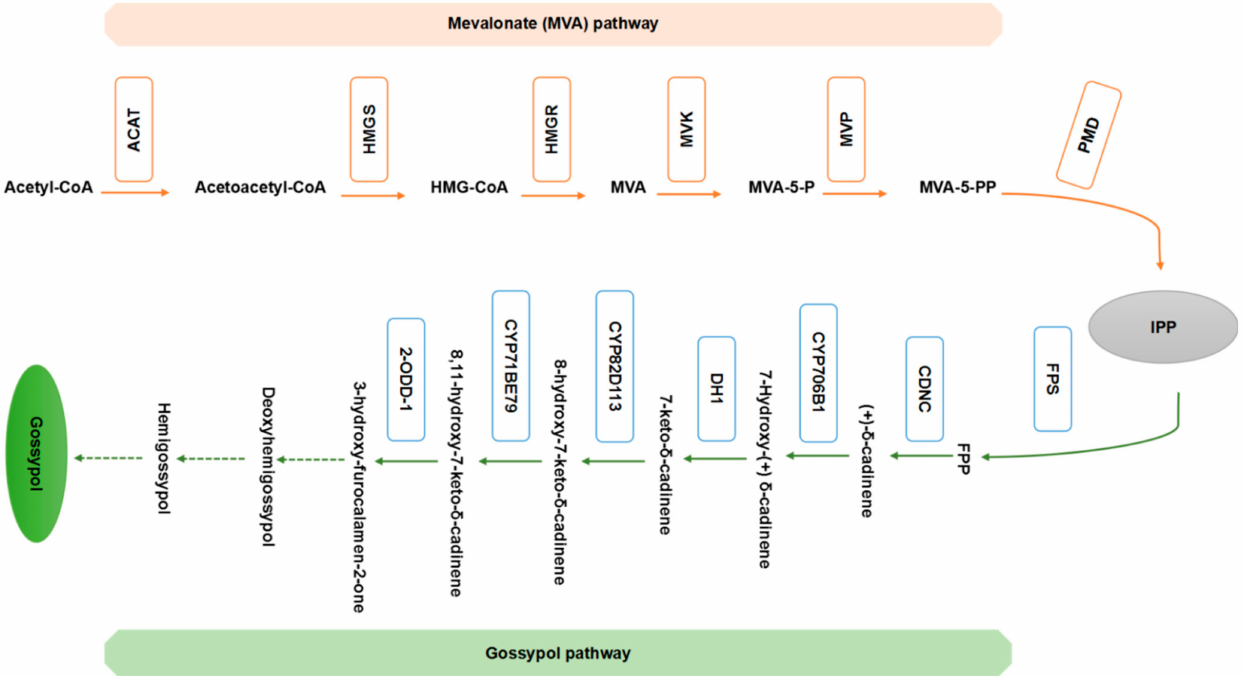
Figure 2. Genes of the mevalonate (MVA) pathway and gossypol pathway and their enzymes. Genes that contribute to the synthesis of gossypol and the enzymes that regulate their expression are presented for each step of the MVA pathway and gossypol pathway. Genes encoding identified enzymes or having expression patterns connected to gossypol biosynthesis are shown at the top. The enzymes involved in the MVA pathway and gossypol pathway, and intermediates include ACAT, acyl CoA-cholesterol acyltransferase; DMAPP, dimethylallyl diphosphate; FPS, FPP synthase; HMGR, HMG-CoA reductase; HMGS, 3-hydroxy-3-methylglutaryl-coenzyme-A (HMG-CoA) synthase; MVK, mevalonate kinase; MVP, phosphomevalonate kinase; PMD, diphosphomevalonate decarboxylase; and IPP, isopentenyl diphosphate. Different enzymes then catalyze the conversion of (+)- δ -cadinene, 7-hydroxy-(+)- δ -cadinene, and 7-keto- δ -cadinene to gossypol. Dashed arrows indicate unidentified reactions of the gossypol